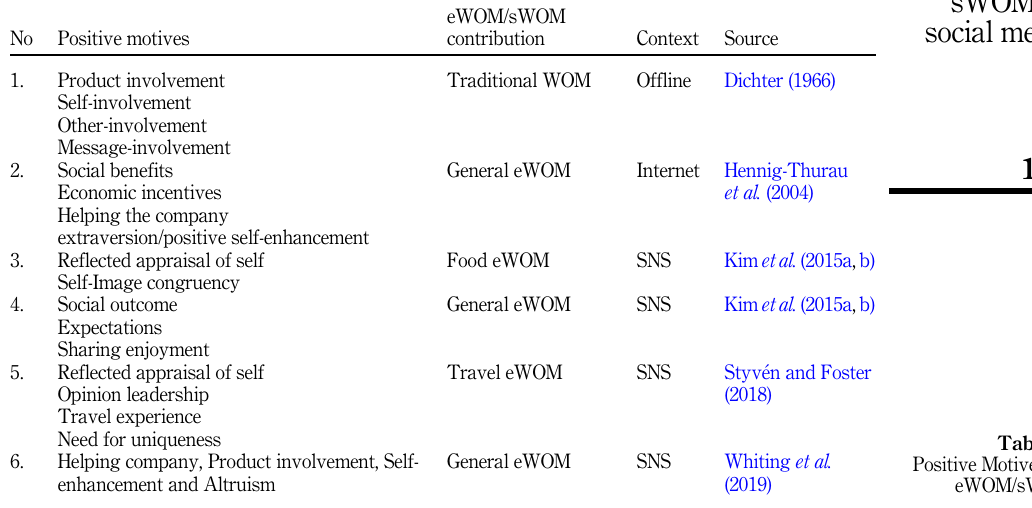
Table 1. Positive Motives